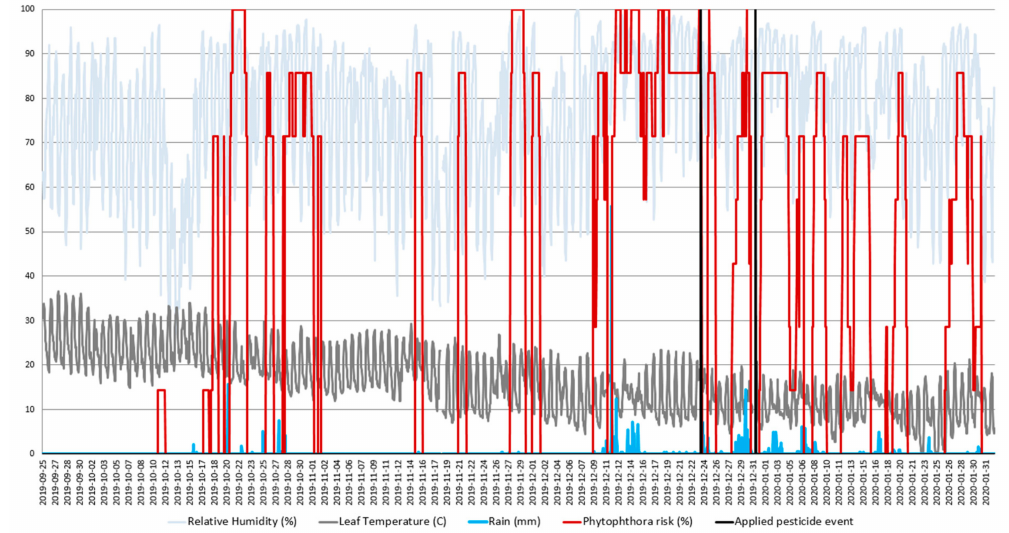
Figure 7. Recorded environmental variables and calculated risk of Phytophthora